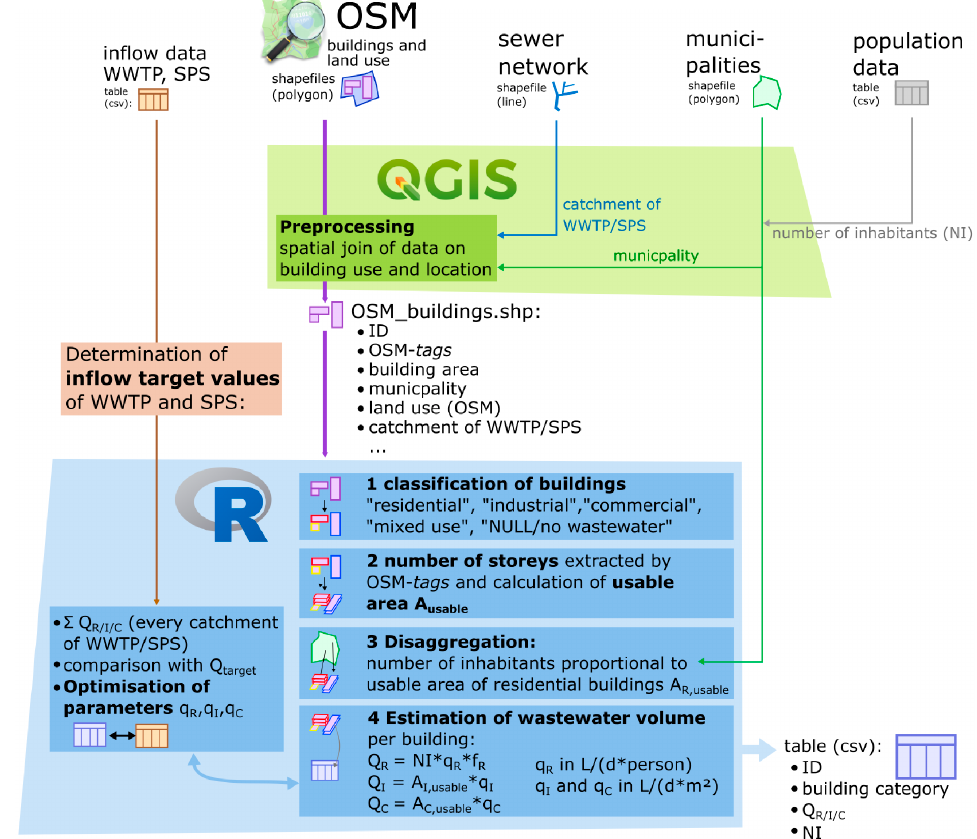
Figure 2. Flowchart of the method for estimating wastewater volumes on a building level.